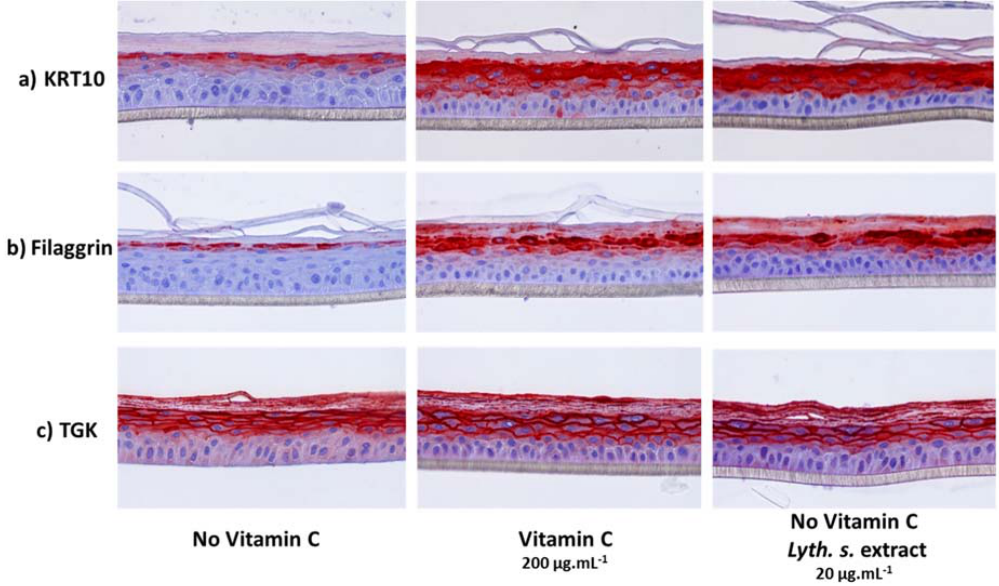
Figure 4. Effect of Lyth. s. extract on reconstructed human epidermis (RHE) differentiation and comparison with the effect of Vitamin C (positive control). After 7 days of treatment, the expression of the epidermis differentiation markers ( a ) KRT10; ( b ) Filaggrin; and, ( c ) TGK was evaluated by immunohistochemistry. Results are from one experiment representative of